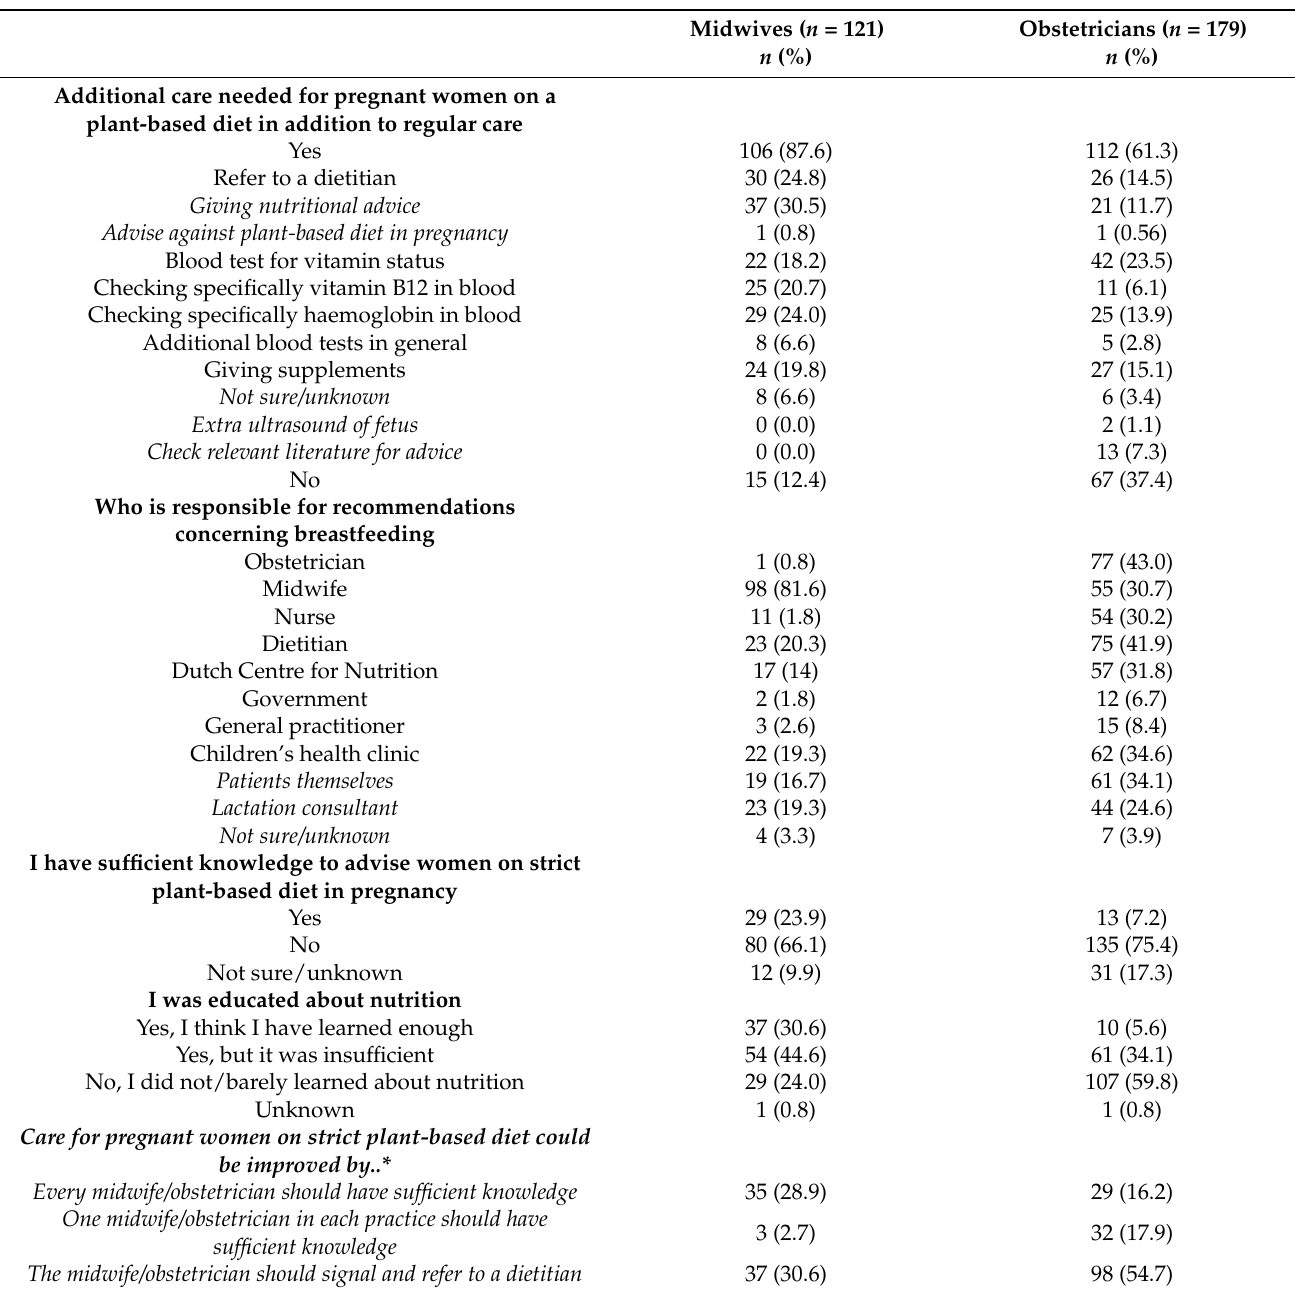
Table 3. Opinions of midwifes and obstetricians on prenatal care and their